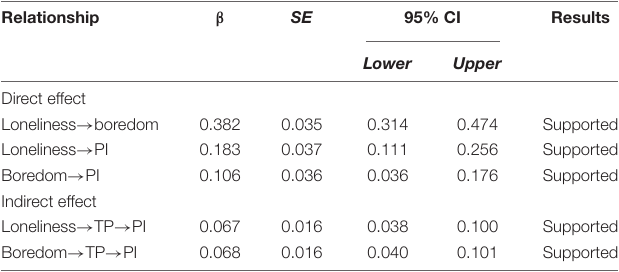
TABLE 3 | Standardized parameter estimates for the direct and indirect effects of the hypothesized model. Relationship